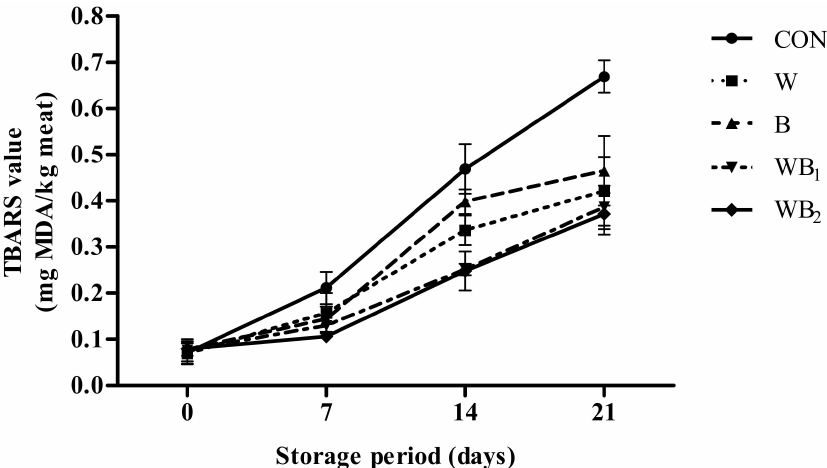
Figure 2. Changes in the 2-thiobarbituric acid reactive substances (TBARS) values of pork patties with di ff erent treatments during refrigerated storage at 4 ◦ C for 21 days. Error bars indicate standard deviations. CON ( • ), control (no additive(s)); W ( (cid:4) ), addition of 2% whey powder; B ( (cid:78) ), addition of 0.5% B. serrata powder; WB 1 ( (cid:72) ), addition of 2% whey powder and 0.5% B. serrata powder; WB 2 ( (cid:7) ), addition of 2% whey powder and 1% B. serrata powder.